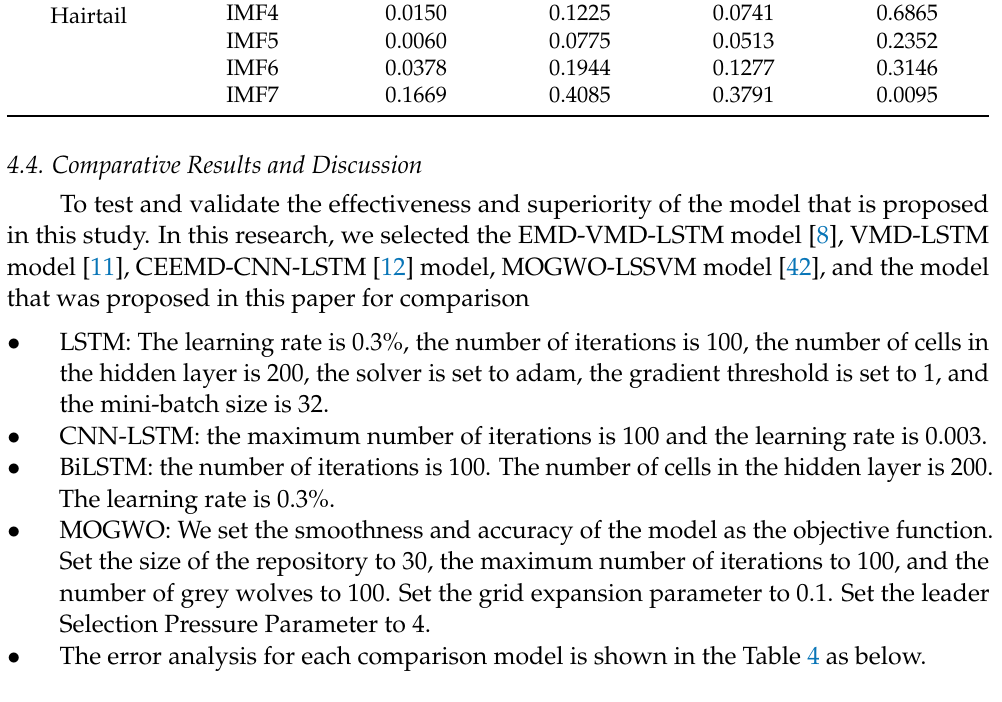
Table 4. Comparison of various models in prediction